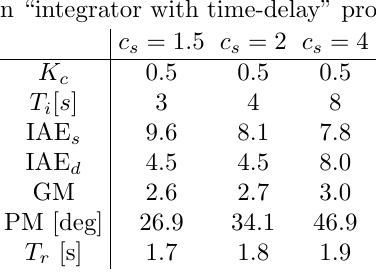
Table 6: Results with c = 1 . 5, c = 2, and c = 4 in the (modified) Skogestad PI tuning formulas for an “integrator with time-delay”